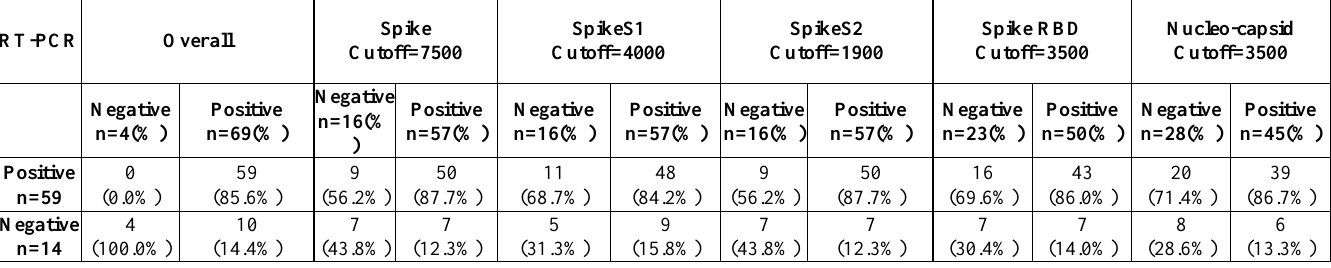
Table S1. Cross tabulation of antibodies against SARSCoV-2 by LABScreen COVID Plus Assay with RT-PCR results.